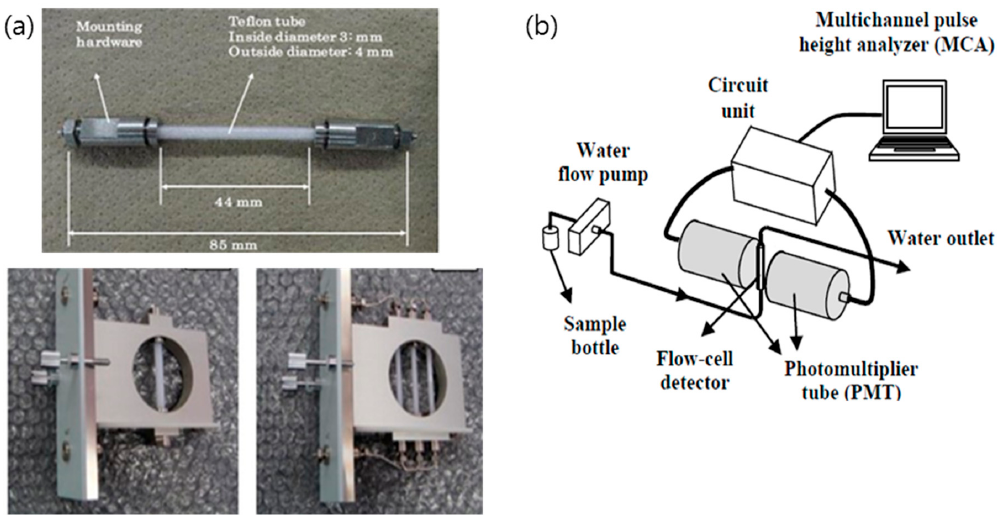
Figure 19. Flow cell system: ( a ) the prototype flow cell, ( b ) composition of the detection system [88,89].